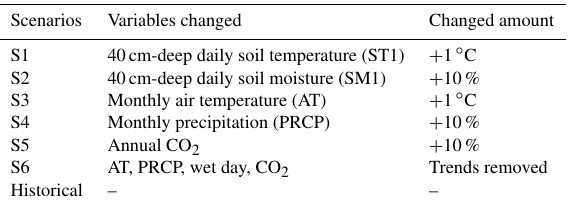
Table 2. Scenarios used for examining the FPC sensitivity to cli- mate